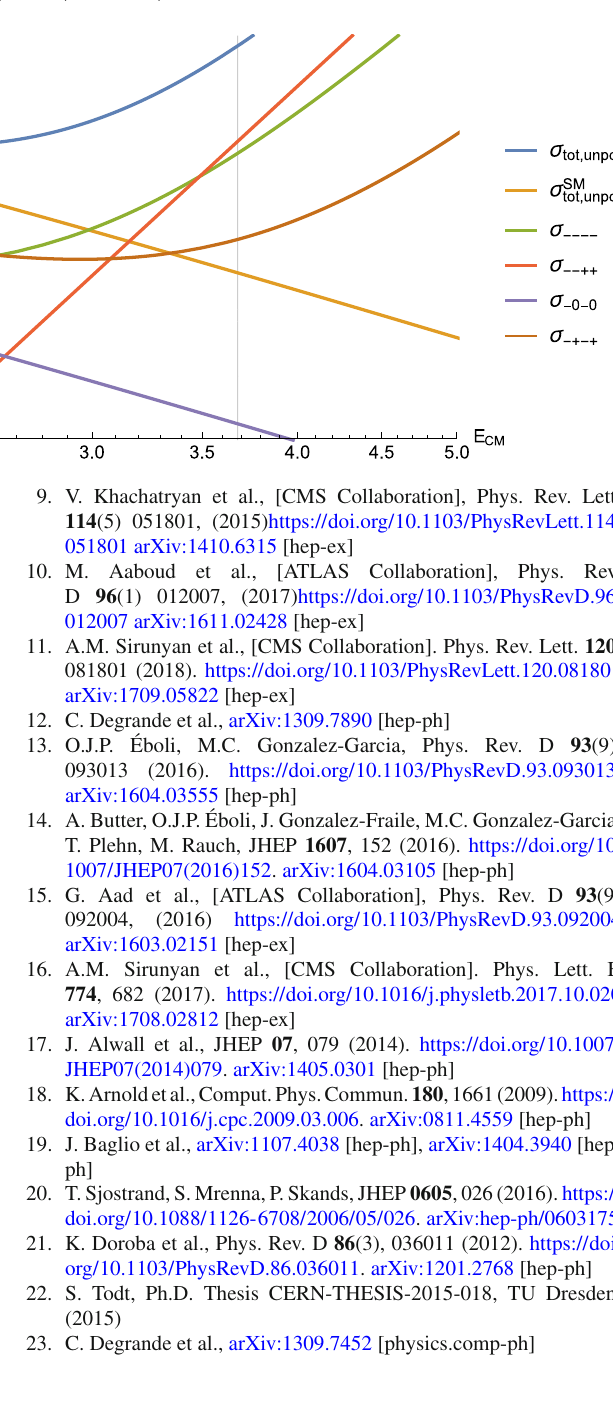
Fig. 11 Contributions of the polarized cross sections (multiplicity taken into account) to the total unpolarized cross section as a function of the center-of-mass collision energy √ s , in TeV) for ( E CM ≡ f T 1 = − 0 . 1 TeV − 4 . The total cross section in shown in blue, the total cross section in the SM is shown in orange. The remaining polarized cross sections are negligibly small